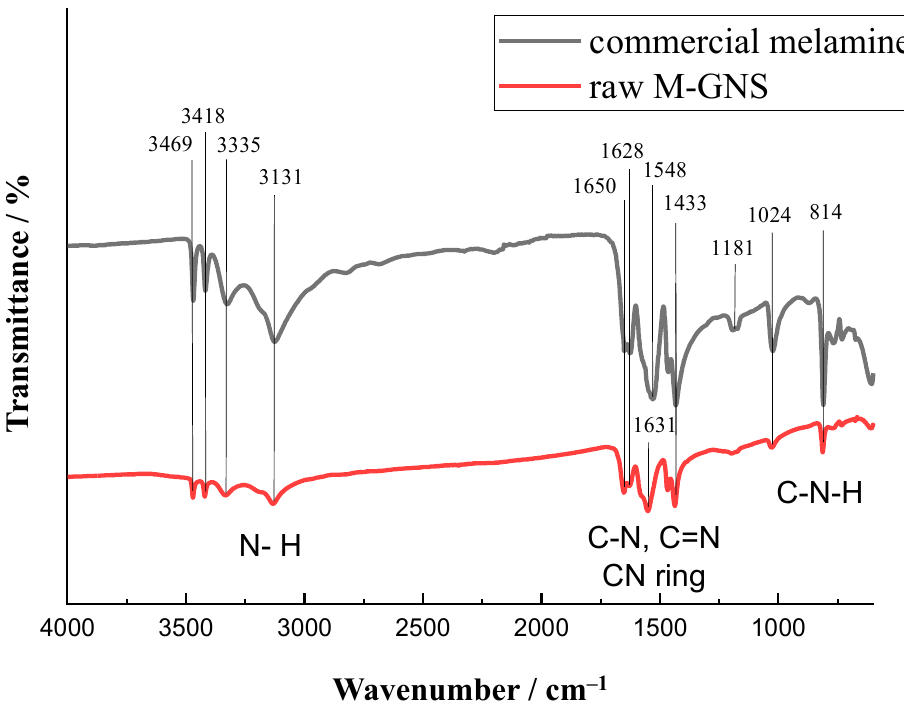
Figure 1. Fourier-transform infrared (FTIR) spectra for the raw sample of melamine-intercalated graphene nanosheets (M-GNS).